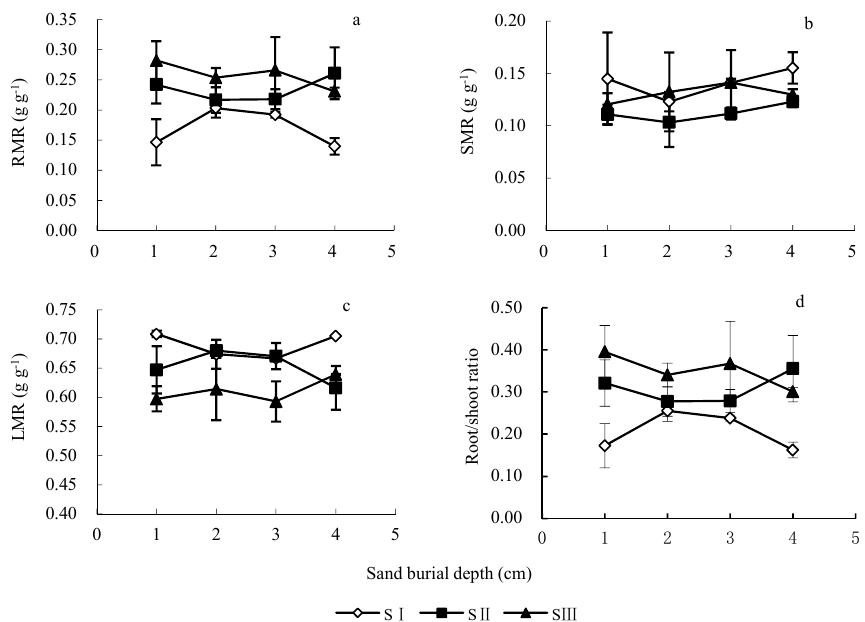
Figure 4. Effects of seed size and sand burial depth on seedling biomass allocation of Pinus thumbergii. RMR ( a ): root mass ratio; SMR ( b ): stem mass ratio; LMR ( c ): leaf mass ratio; root/shoot ratio ( d ). SI: large seeds; SII: medium seeds; SIII: small seeds. Values are means ± standard deviation (SD).